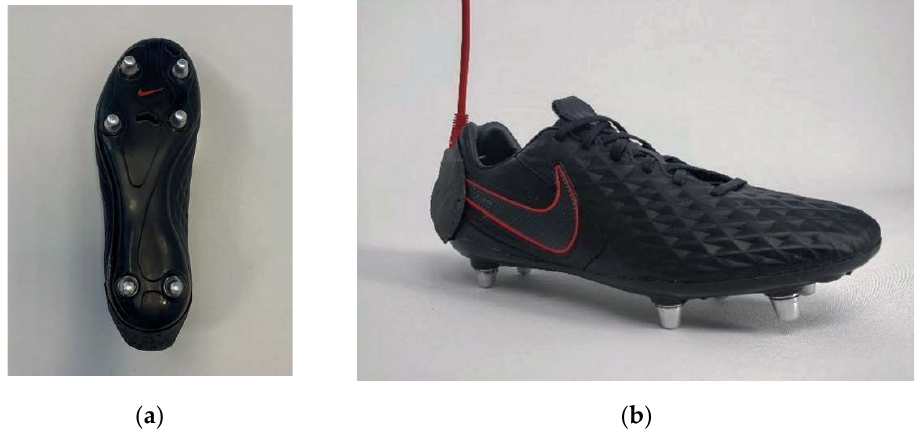
Figure 2. ( a ) Football shoe with six instrumented studs in the transversal plane ( b ) and integrated electronics at the back.